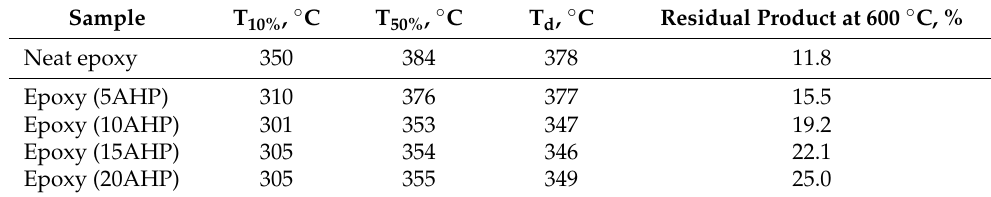
Figure 4. Comparative TG traces of epoxy/AHP nanocomposites and blank epoxy resin under nitrogen (heating rate: 10 ◦ C/min). Table 2. TGA data obtained following the characterization of epoxy/AHP nanocomposites under nitrogen.